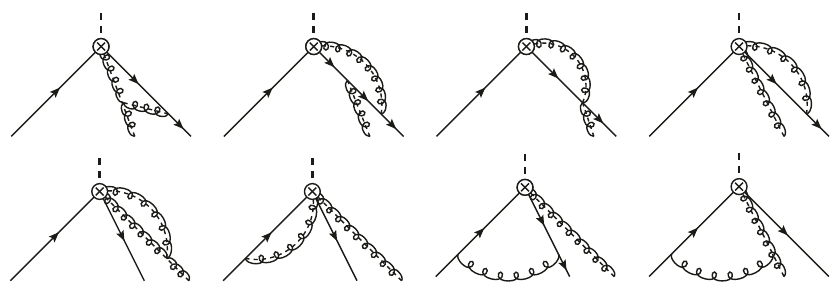
q (cid:22) qG in (5.10). The short